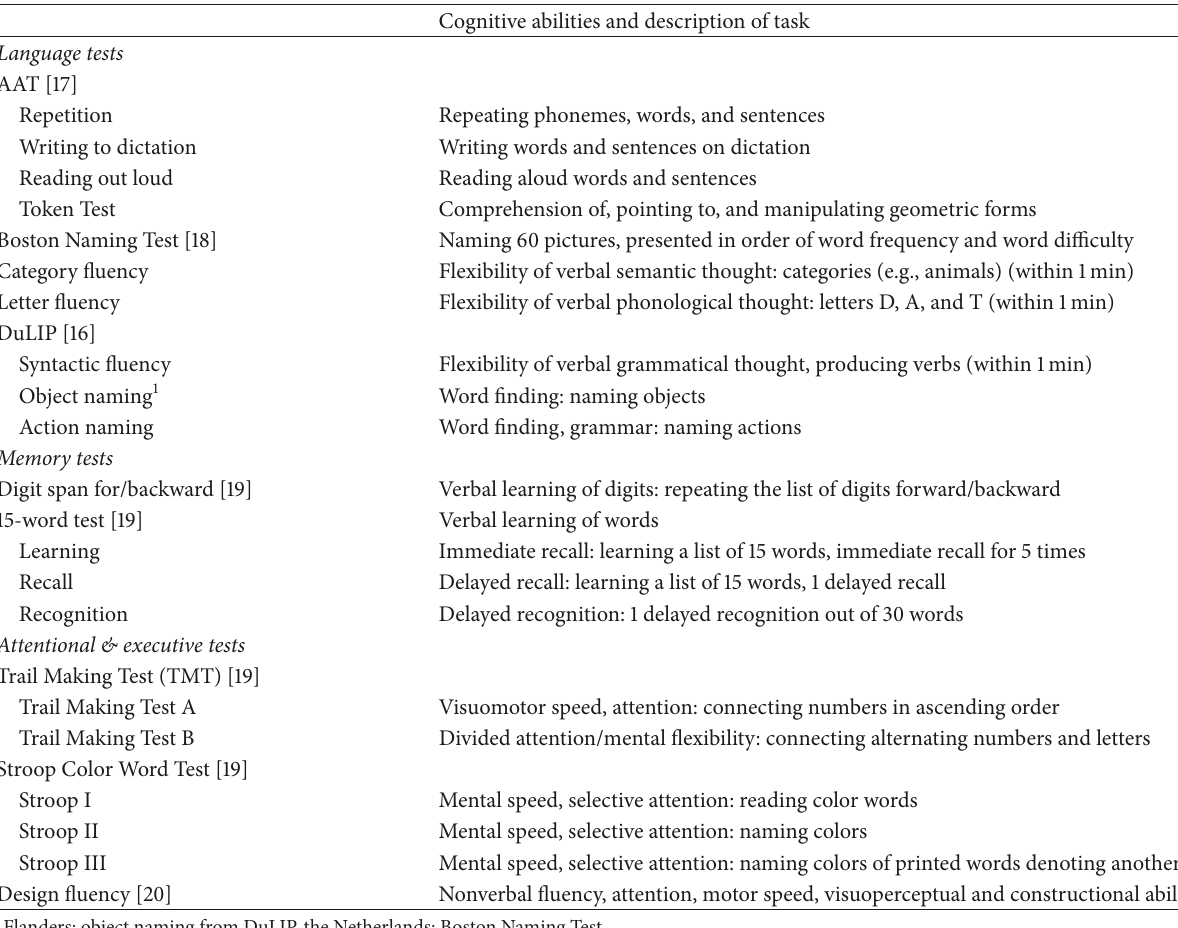
Table 2: Neuropsychological